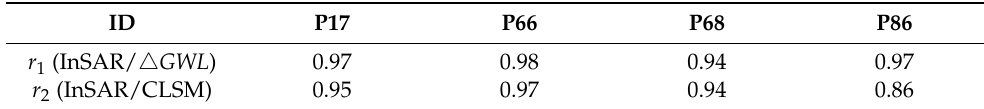
Figure 9. Comparison among InSAR, GRACE, CLSM, and △ GWL sequence during 2017–2020. ( a – d ) The original sequence comparison at the in situ points of P17, P66, P68, and P86, respectively; ( e – h ) The correlations of trend components between subsidence and groundwater changes at the four in situ points. Table 2. Correlation coefficients between subsidence and △ GWL at the four in situ points (P17, P66, P68, and P86).